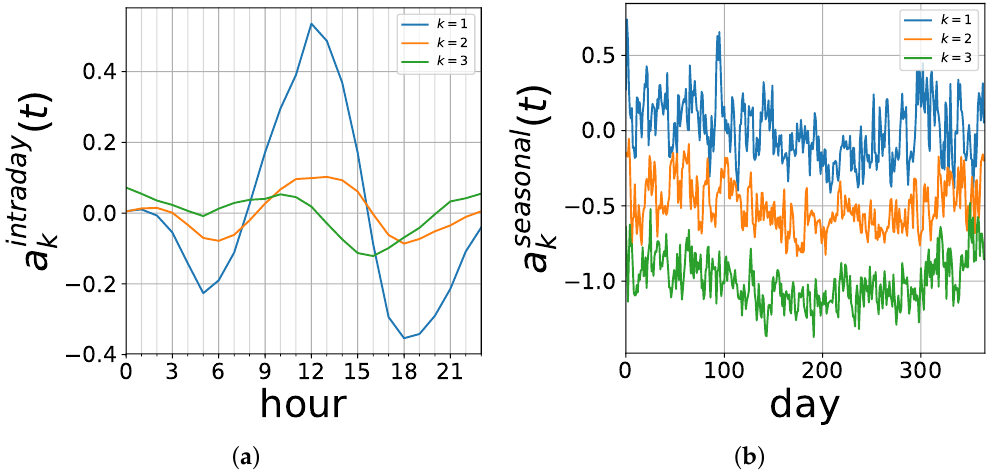
Figure 7. ( a ) Intraday and ( b ) seasonal amplitude profiles of the first three principal components for α = 0.8. The seasonal amplitude profiles for k = 2 and k = 3 have been artificially shifted by − 0.5 and − 1.0,